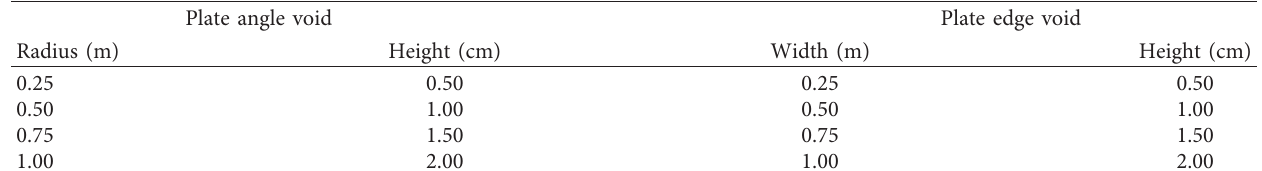
Table 1: Size setting of void